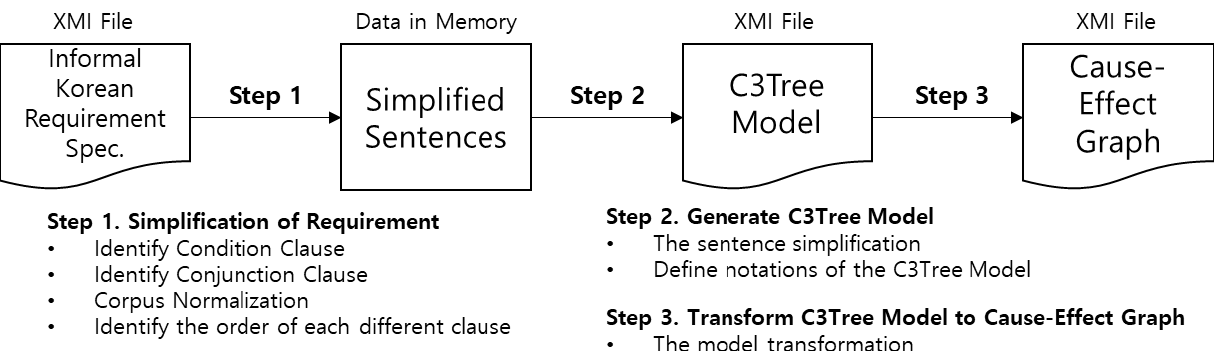
Figure 3. The Process of Cause-Effect Graph Generation from Informal Requirement Spec.